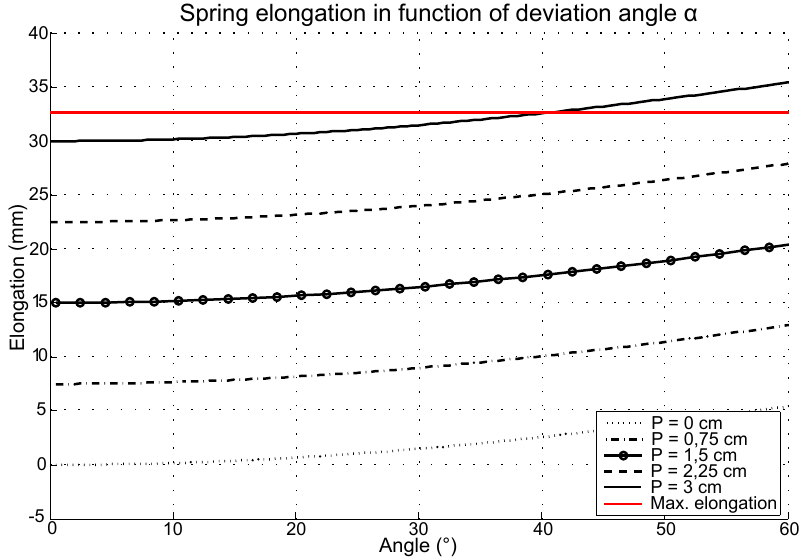
Figure 8. The elongation of the spring as a function of deviation angle α for different pre-tension values and the maximum allowed elongation of the chosen